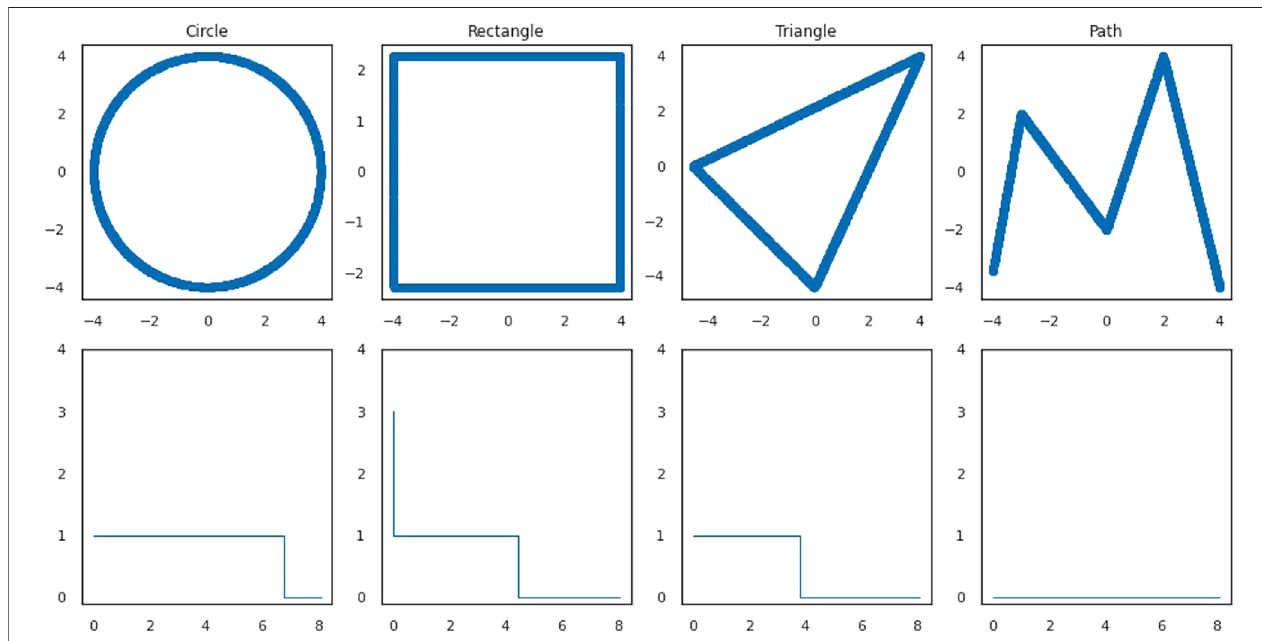
FIGURE 1 | First row: a dense point cloud sampling without noise from each of the shapes. Second row: the corresponding standard stable ranks of the persistence modules given by the 1-st homology of the Vietoris-Rips complexes of the distances given by the restriction of the Euclidean metric to the point clouds.